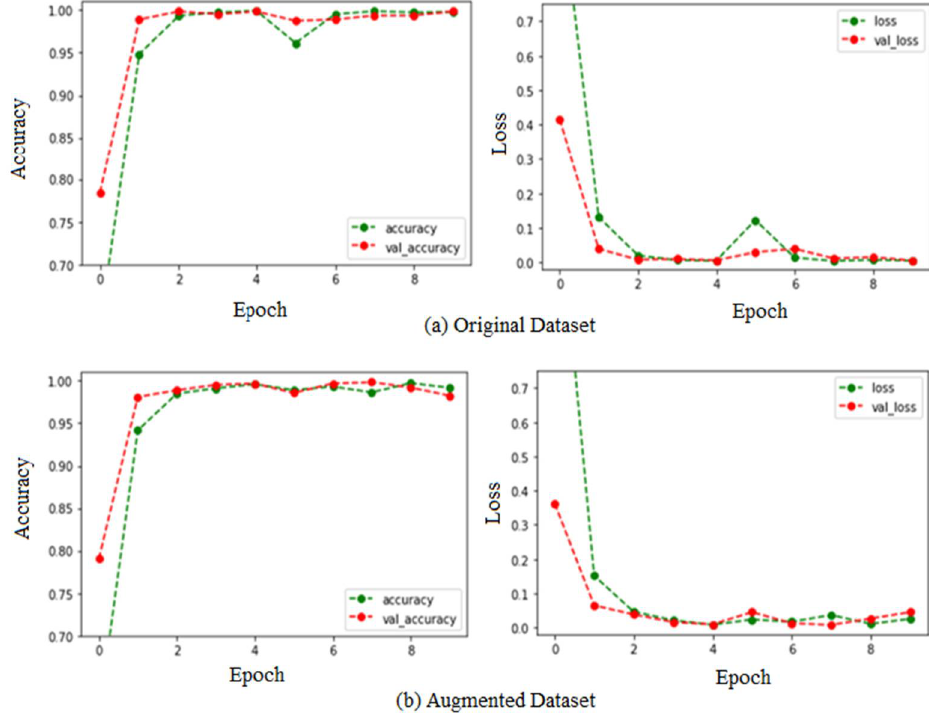
Figure 7. Loss and accuracy graph of CNN model for ( a ) original dataset and ( b ) augmented dataset.